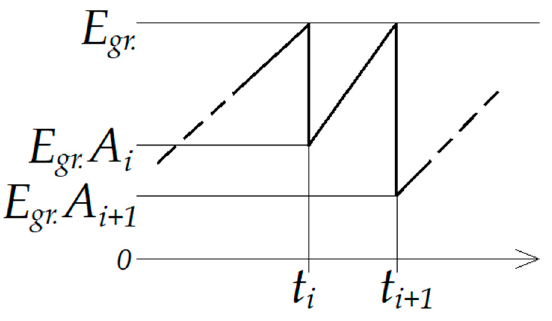
Figure 10. The schematic E(t) plot of the corona discharge model inside the cloud.